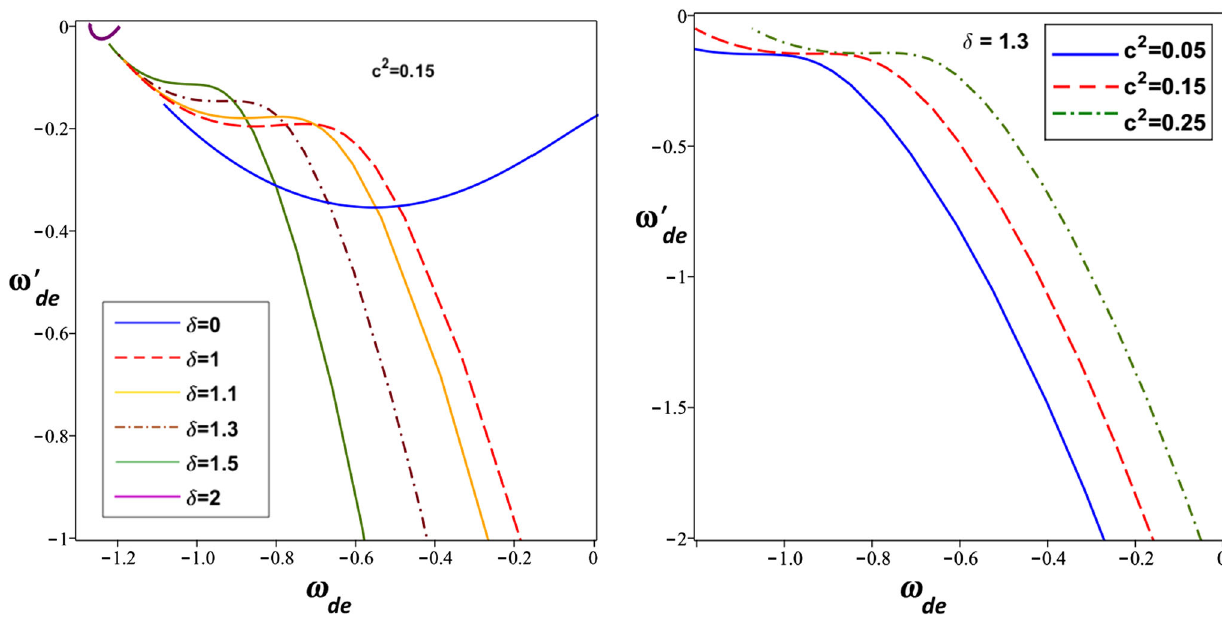
= 0 . 73, u = 0 . 3 and c 2 = 0 . 15 de